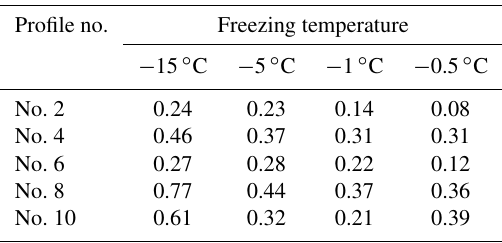
Table 4. The normal shear dilatancy at the point of peak shear strength